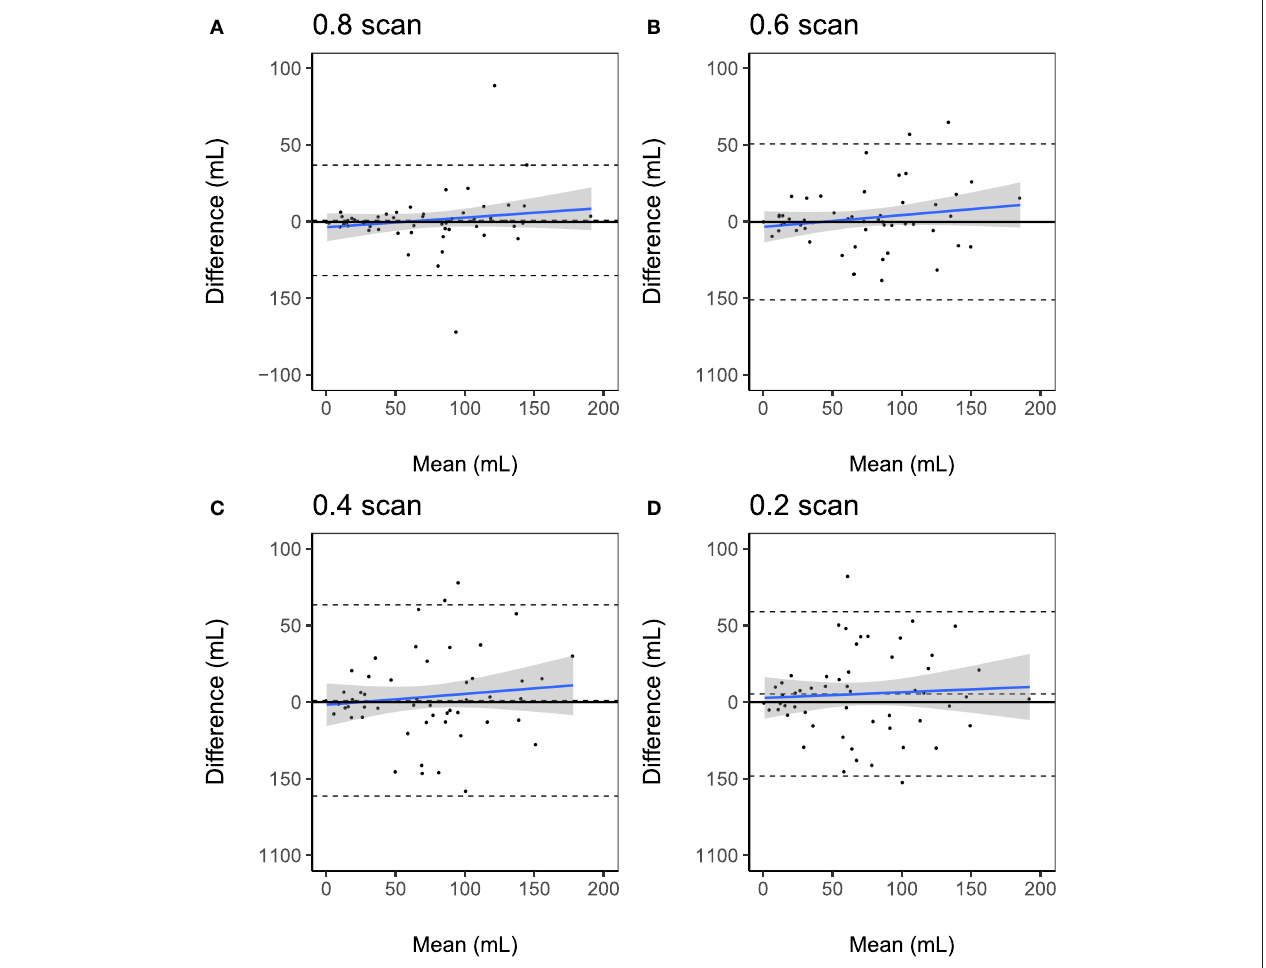
FIGURE 3 | Bland-Altman plots of volumetric agreement between BOLD delay lesion volumes derived from resting-state functional MRI scans of different lengths (A) 0.8 scan, (B) 0.6 scan, (C) 0.4 scan, (D) 0.2 scan and BOLD delay lesion volumes derived from the full scans. The upper and lower dashed lines represent the 95% limits of agreement and the middle dashed lines represent the bias (mean difference). The blue solid line and shaded gray region represent the regression lines and 95% confidence interval of the regression lines, respectively.